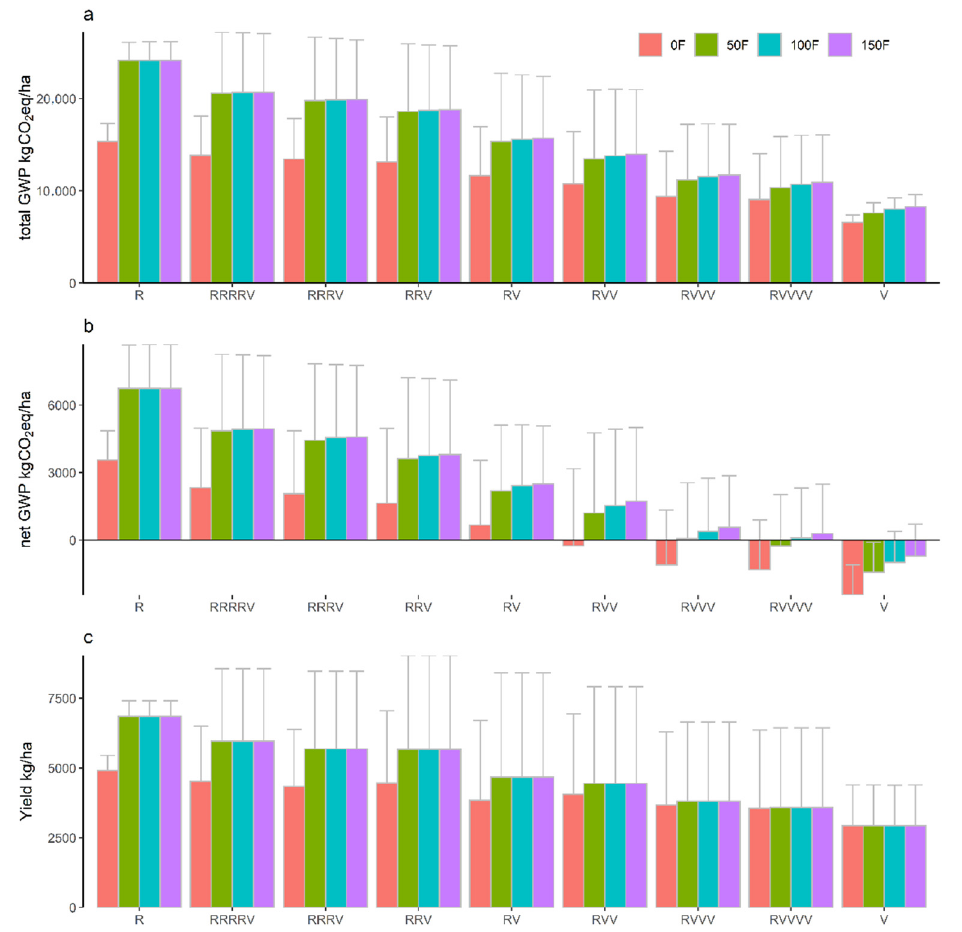
Figure 7. Average annual ( a ) total global warming potentials (GWPs), ( b ) net GWPs and ( c ) annual crop yields across the 40-year simulations as influenced by cropping systems and fertilizations. R and V represent a rice year or vegetable year, respectively; 0, 50, 100 and 150 F represent 0, 50, 100 and 150% of the conventional fertilization level in the experiment.